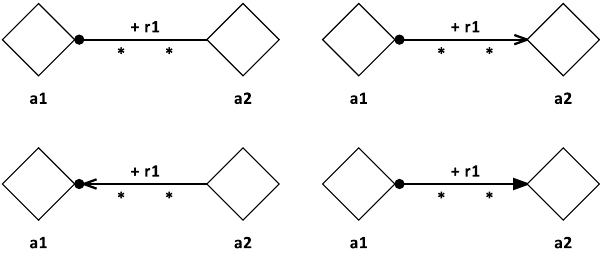
Fig. 11. Graphical representation of roles ( Role ) of di®erent navigability and direction.